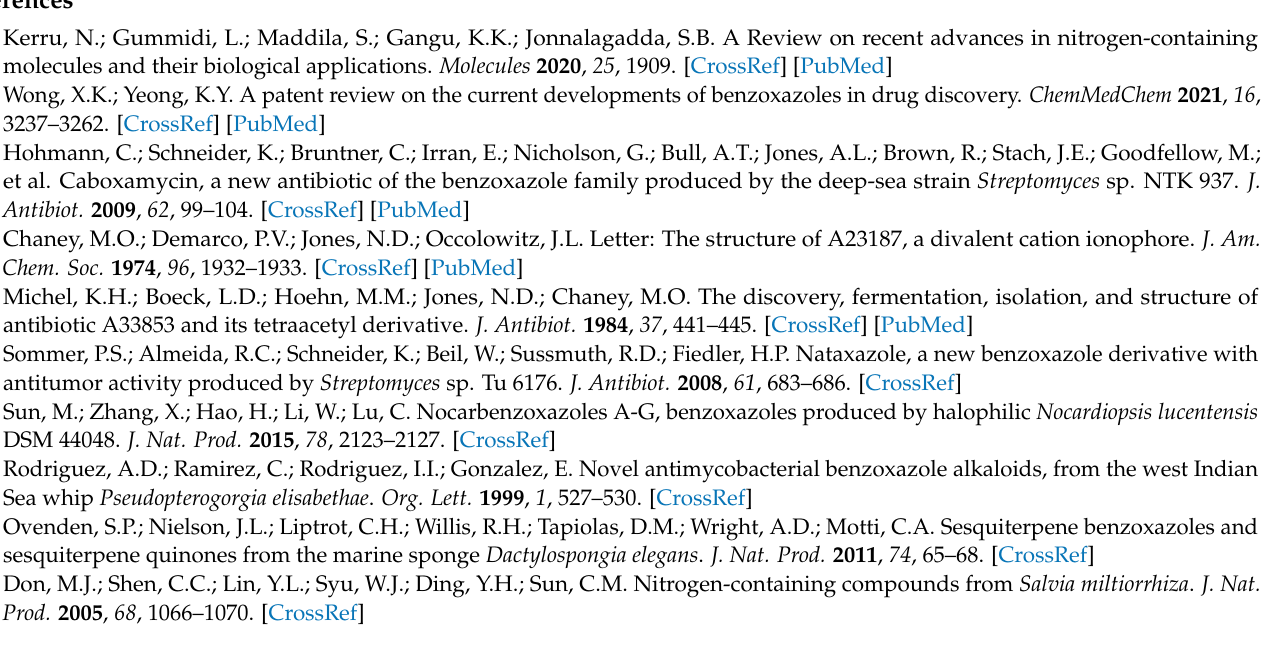
Table S3. Primers were used in this study. Table S4. The antibacterial activities of compound 1 – 6 . Figure S1. The representative biosynthetic pathway of benzoxazoles. Figure S2. The spectroscopic data of 1 . Figure S3. The spectroscopic data of 2 . Figure S4. The spectroscopic data of 3 . Figure S5. The spectroscopic data of 4 . Figure S6. The spectroscopic data of 5 . Figure S7. The spectroscopic data of 6 . Refs [26,27,31,32] are cited in the Supplementary